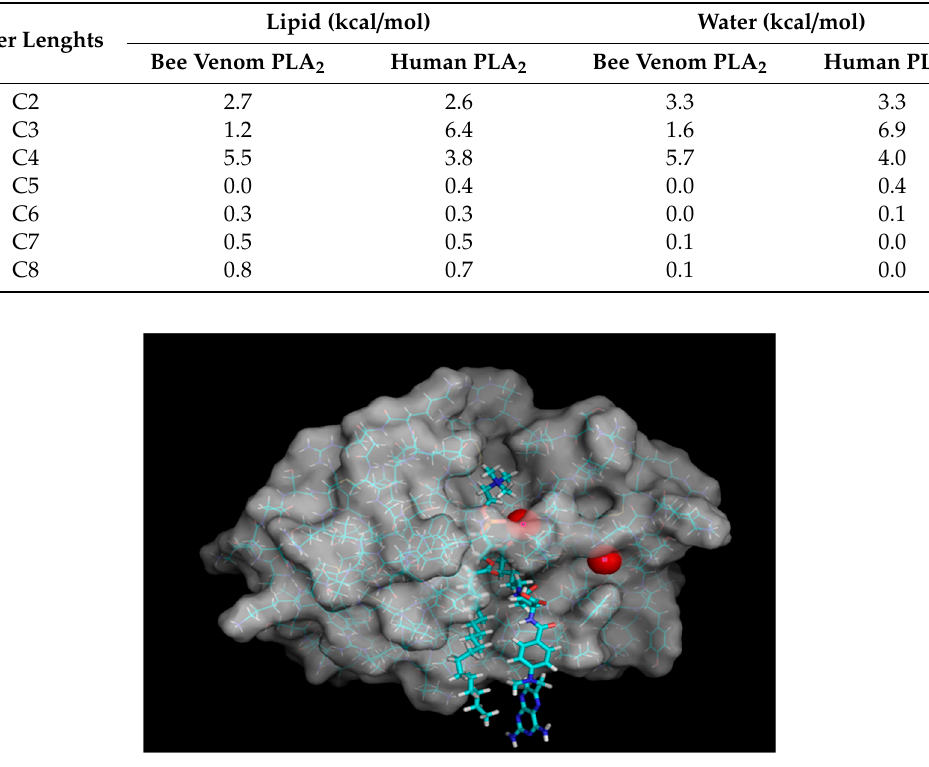
Figure 8. Optimized transition state geometries of human PLA 2 /PL-methotrexate prodrug complex with a 5-carbon linker. PLA 2 , phospholipase A 2 ; PL, phospholipid.